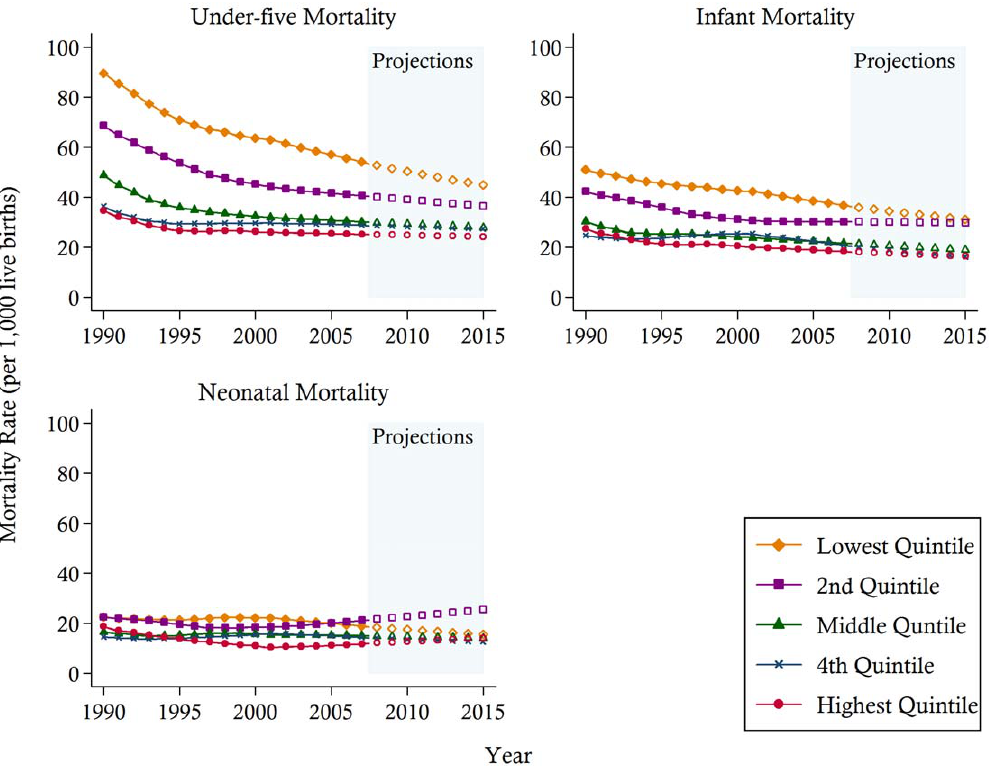
Figure 3. Under-five, infant, and neonatal mortality rates (per 1,000 live births) between 1990 and 2007 and projections towards 2015 in the Philippines by wealth groups. Notes : Data are from Demographic Health Surveys 1993, 1998, 2003, and 2008. The solid lines represent the mortality estimates calculated using direct methods. DHS, Demographic Health Survey.